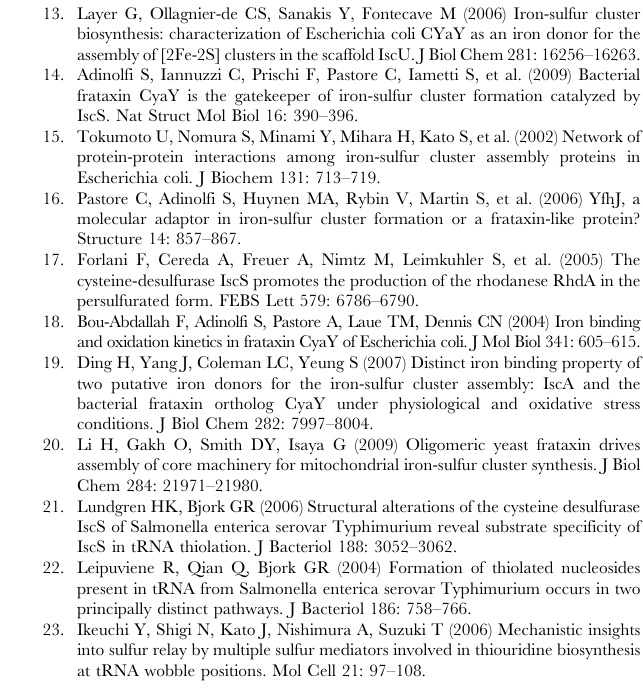
IscU, and CyaY, showing that they formed a ternary complex. (C) Formation of a ternary complex between His-IscS, IscU, and IscX was determined using similar procedure as above. (D) Competition between TusA and IscX for IscS. Only His-IscS and IscX eluted after second TEV cleavage. (E) Competition between TusA and CyaY for IscS. Only His-IscS and CyaY eluted after second TEV cleavage. Figure S7 Models of the IscS-CyaY complex with restraints from NMR (CyaY) and mutagenesis (IscS). The location of IscU (wheat) relative to IscS is also shown. Figure S8 Superposition of IscS and SufS. The conforma- tion of the loop bearing the active site cysteine is significantly different in both proteins. Table S1 Oligonucleotides used for construction of iscS::kan (IC6087) and tusA::kan (IC6085) strains. Found at: doi:10.1371/journal.pbio.1000354.s009 (0.04 MB